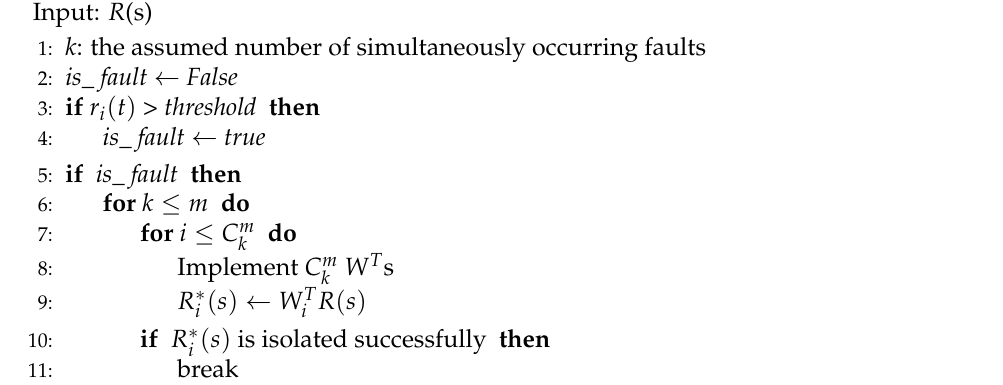
Algorithm 1 Fault isolation with structural residual